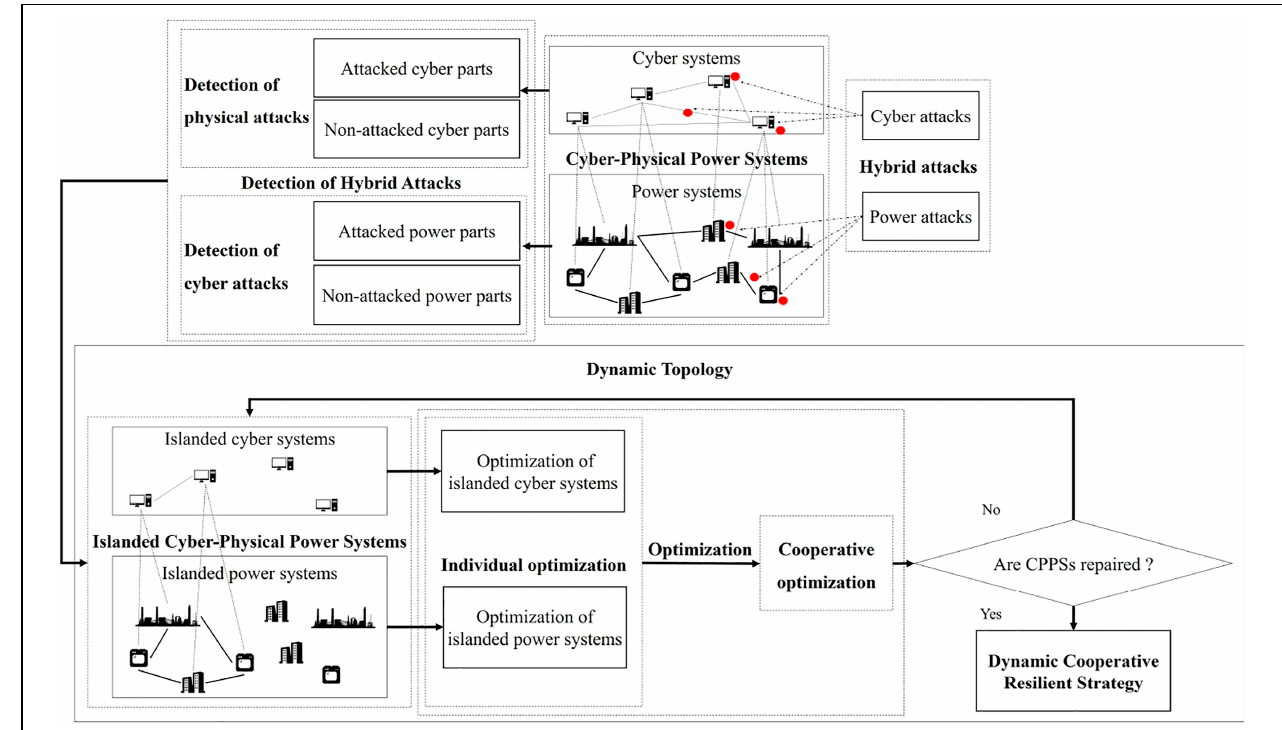
FIGURE 1 | Structure of this